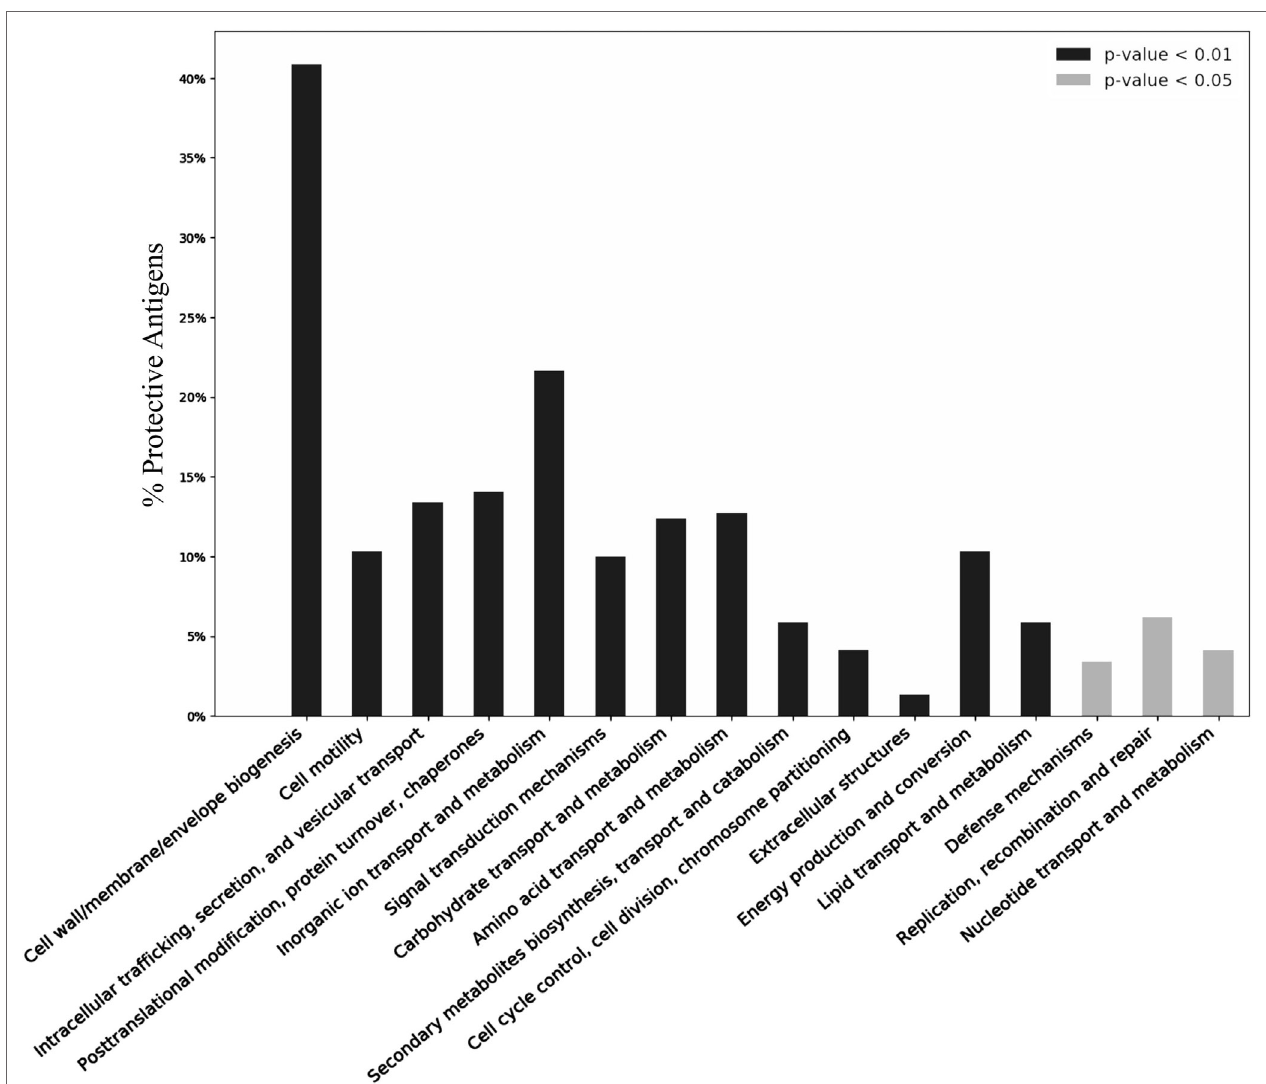
FigUre 4 | Over-representation of COG clustering profiles among reported protective antigens (PAgs). Over 40% of the reported PAgs belong to the cluster “Cell wall/membrane/envelop biogenesis,” which agrees with common knowledge of using surface-exposed proteins as a key criterion in vaccine antigen prediction. Other COG clusters related to pathogen motility, secretion, signal transduction, and transportation are also significantly enriched in PAgs as compared with non-protective proteins. See the text for detailed discussion. The significant over-representation of PAgs’ COG clusters compared with non-protective proteins is colored with gray ( p < 0.05) and black ( p <